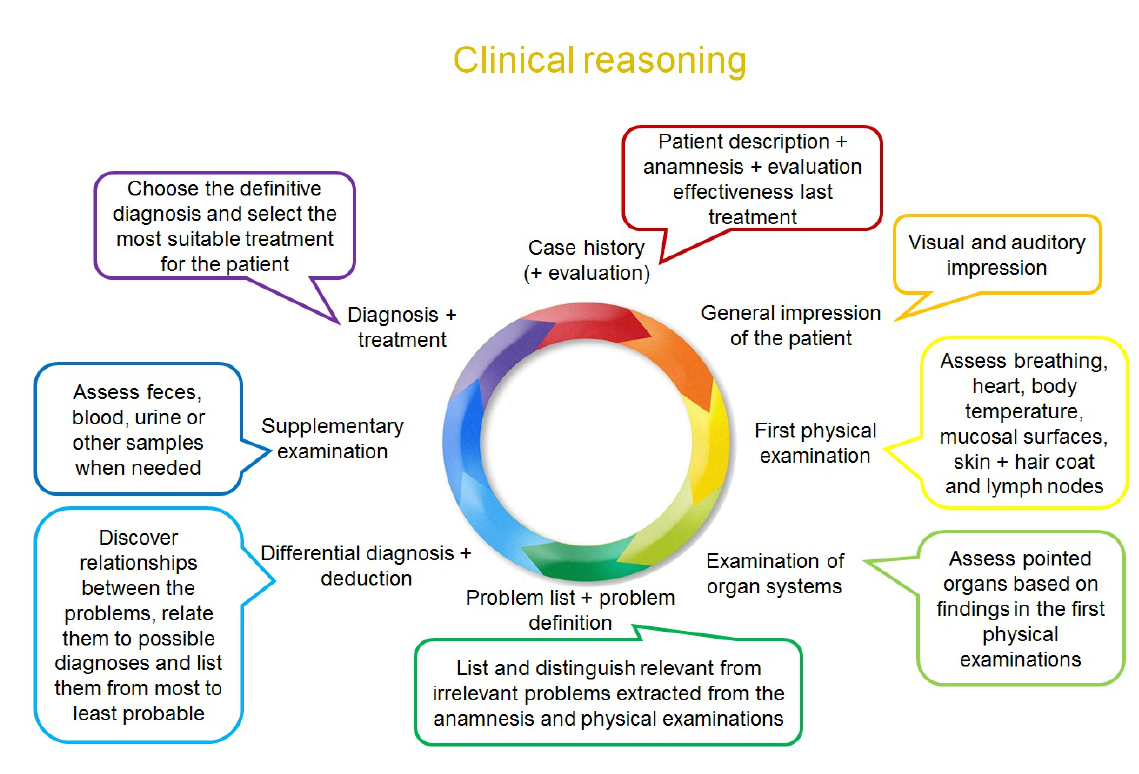
Figure 1. An overview of the clinical reasoning